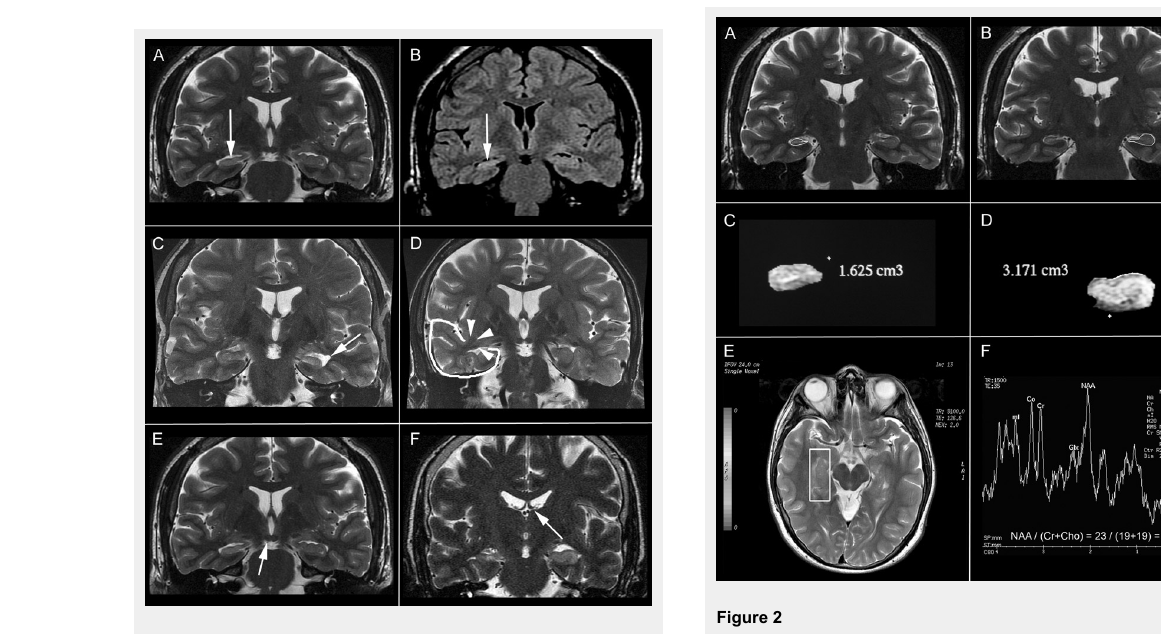
A and B coronal T2-weighted MRI showing the countours of hippocampi as part of the 3D volumetry. C and D, 3D reconstruction of the hippocampus showing a decreased-volume hippocampus and a superior normal limits hippocampus. E, axial-oblique plane showing the location and size of the voxel. F, MR spectrum in a case with MTS depicts an abnormal spectrum with decreased NAA/ (Cr+Cho) ratio and increase in the